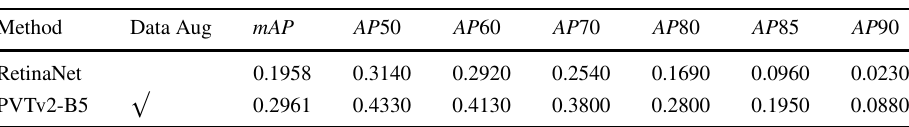
grained classification experiments on HRSC2016